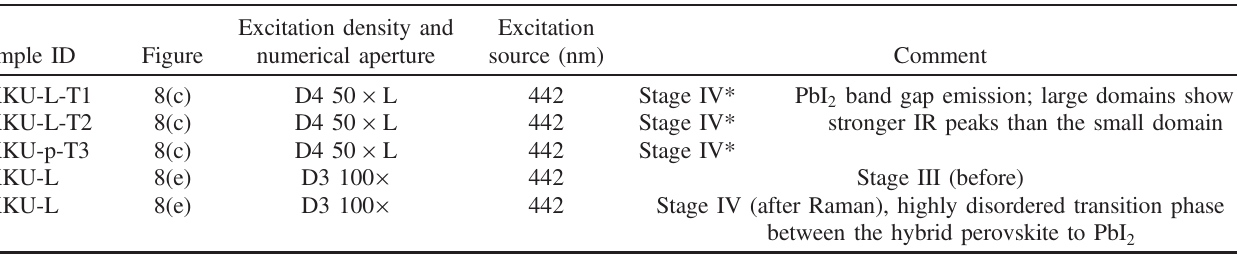
TABLE V. Summary of PL data in Fig. 8. All PL spectra are measured under TAT = CT ¼ 1 s = 1 s. The asterisk indicates a light- induced degradation